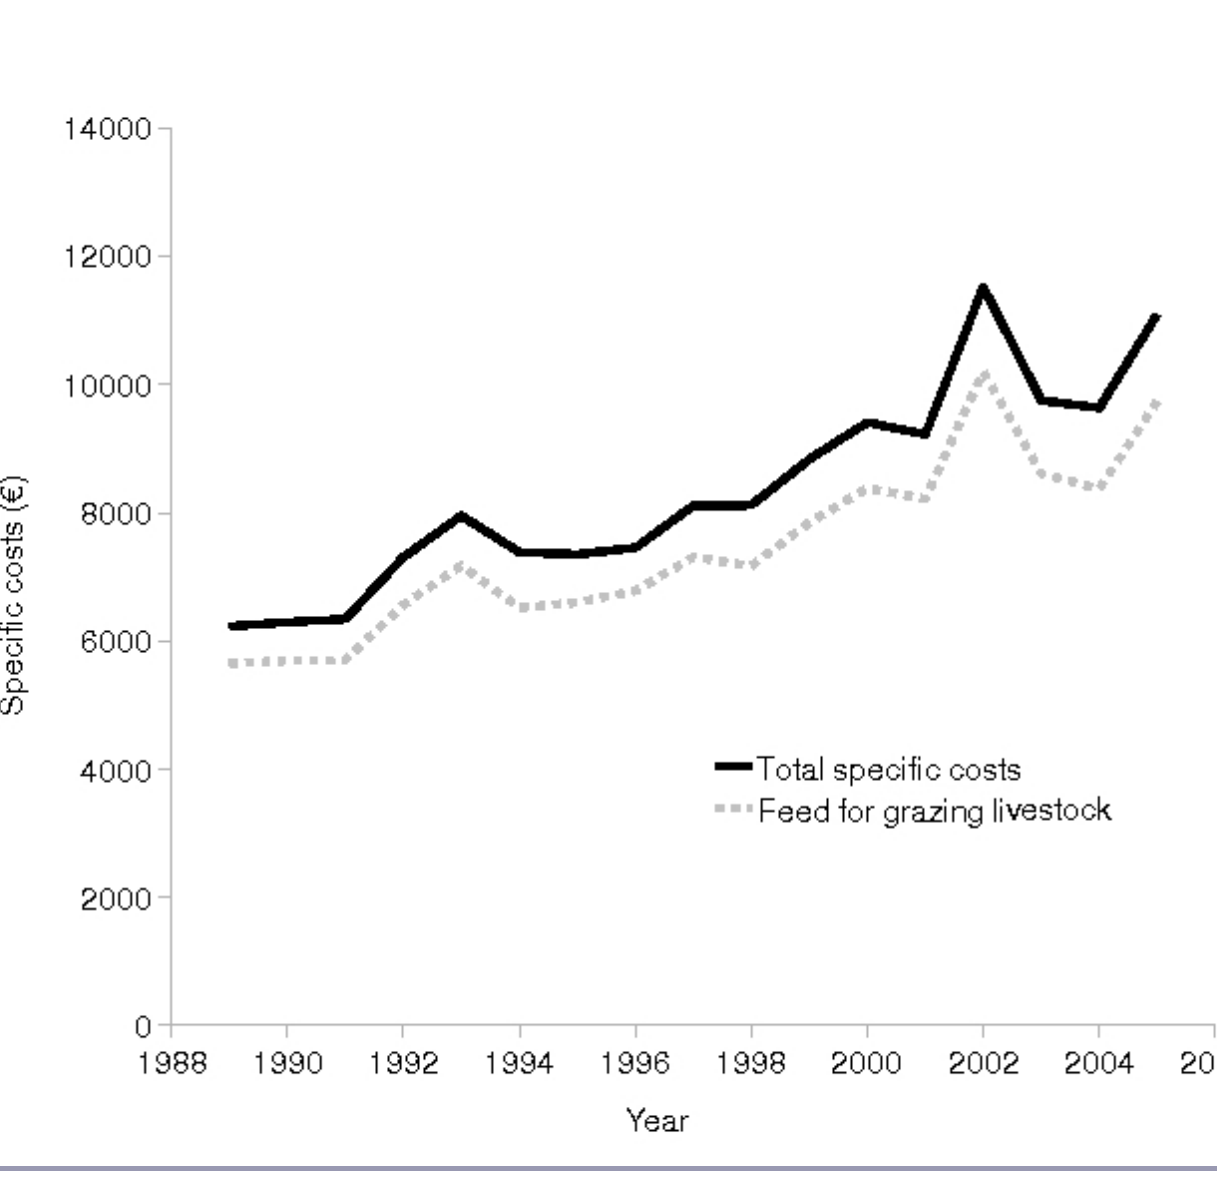
Figure 8. Average livestock specific costs for sheep and goat specialists in Crete between 1989–2005